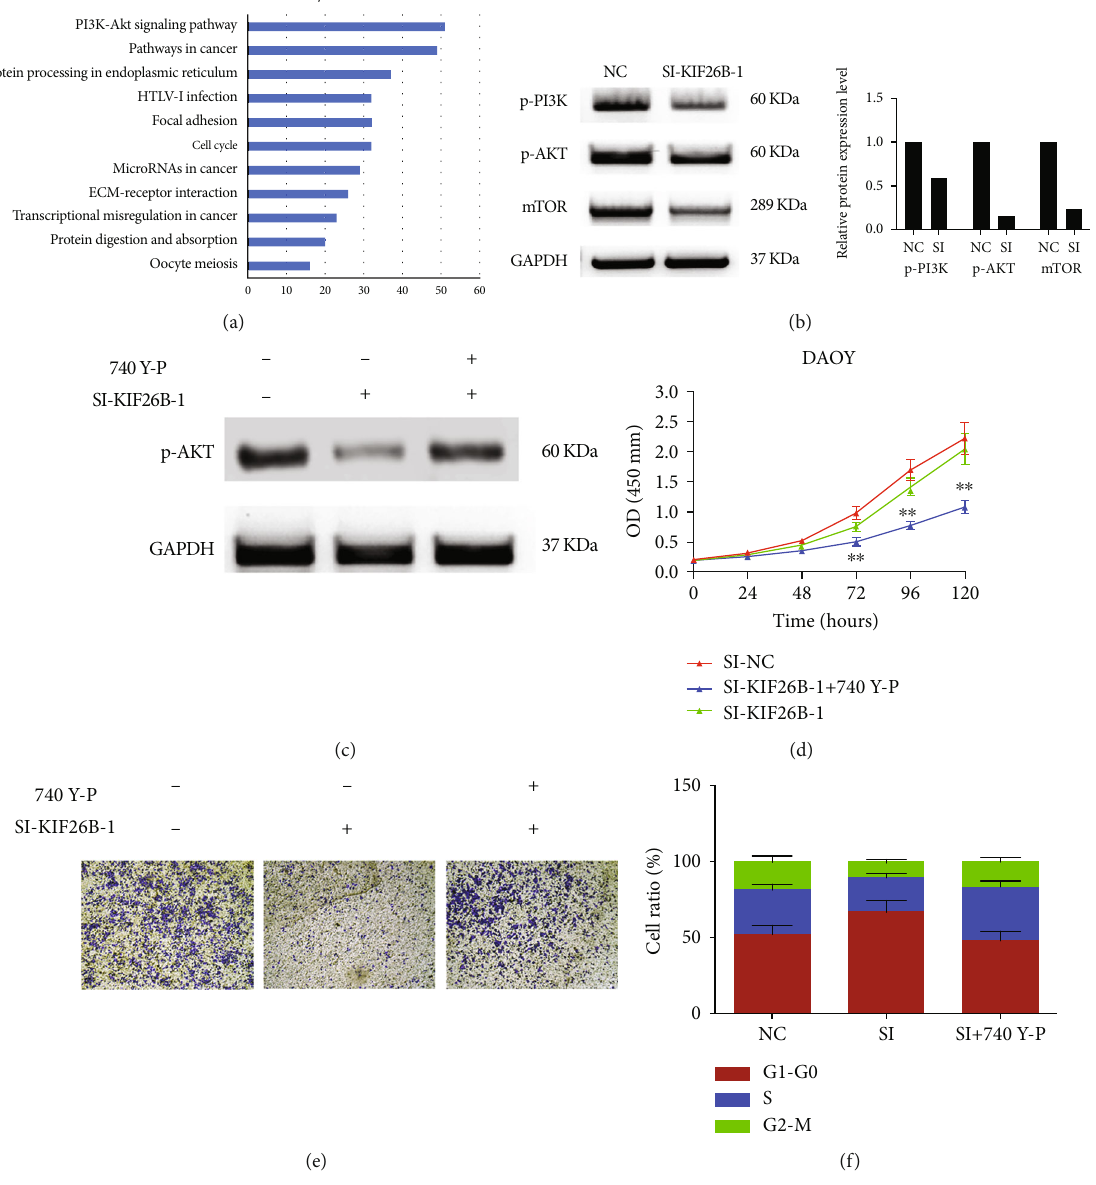
Figure 4: (a) Genes highly correlated with KIF26B expression were analyzed using KEGG enrichment analysis. The PI3K-Akt signal pathway ranks fi rst. (b) Western blot was used to detect the expression of key proteins in the PI3K-AKT signaling pathway after knocking down KIF26B. (c) Western blot was used to detect the expression of phosphorylated AKT after knocking down KIF26B and adding PI3K pathway activator 740 Y-P with concentration of 20 μ M. (d, e, and f) After adding the PI3K pathway activator 740 Y-P (20 μ M), the proliferation (d), migration (e), and cell cycle (F) of DAOY cells were observed